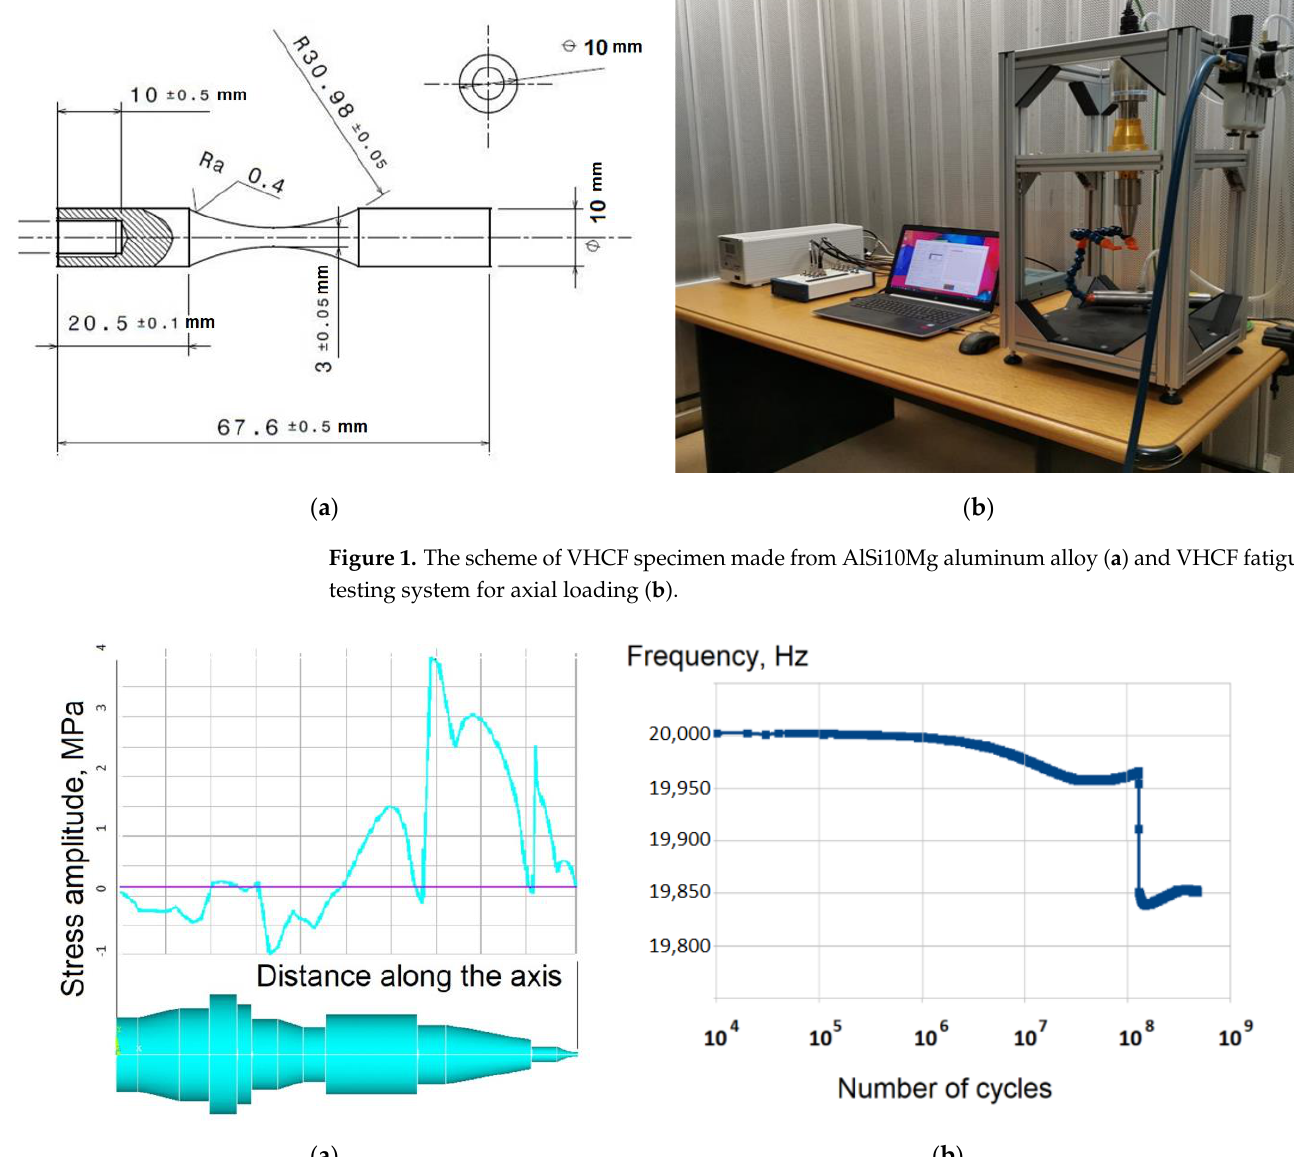
Figure 1. The scheme of VHCF specimen made from AlSi10Mg aluminum alloy ( a ) and VHCF fa- tigue testing system for axial loading ( b ).